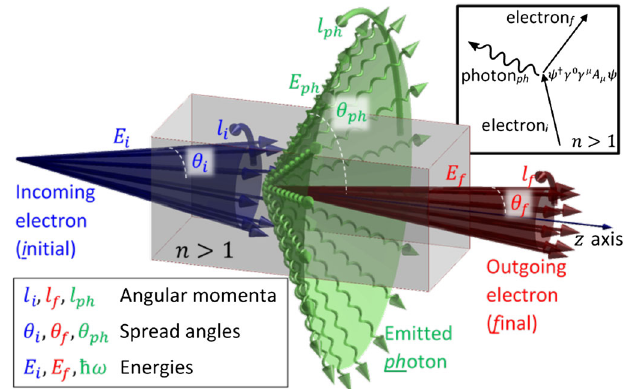
FIG. 1. Illustration of the Č R process. The incoming (outgoing) electron is drawn in blue (red), and the emitted photon in